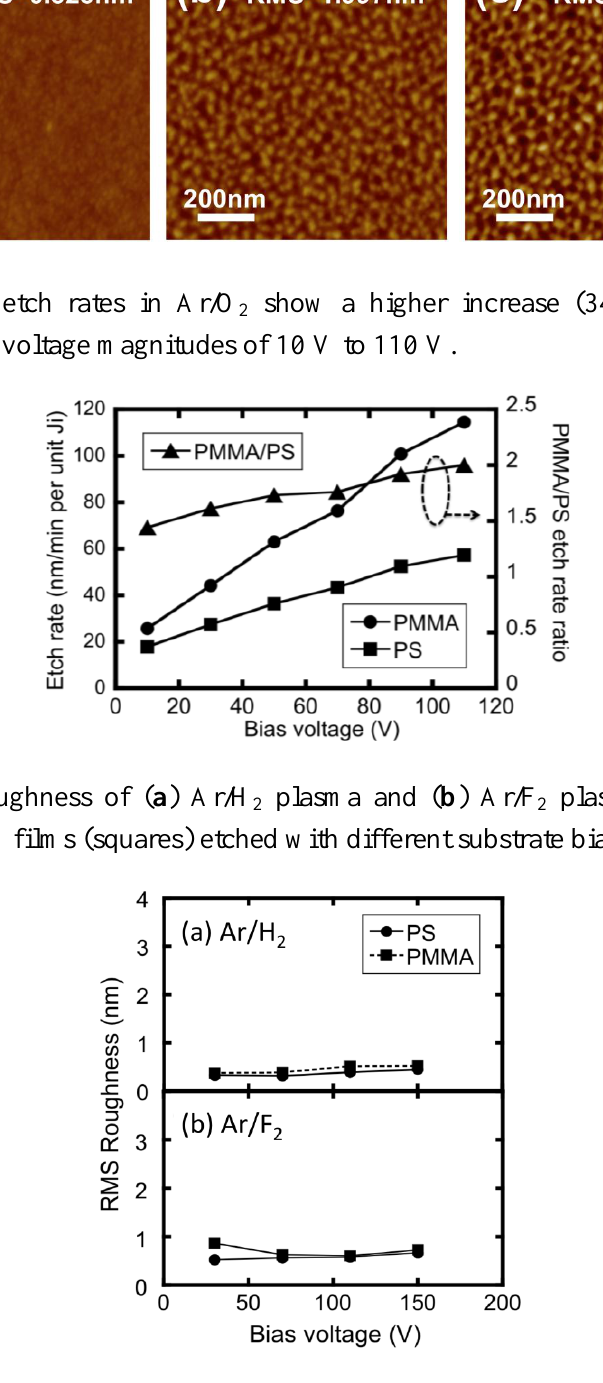
Figure 5. AFM images of Ar/O ( b ) −60 V and ( c ) −110 V.